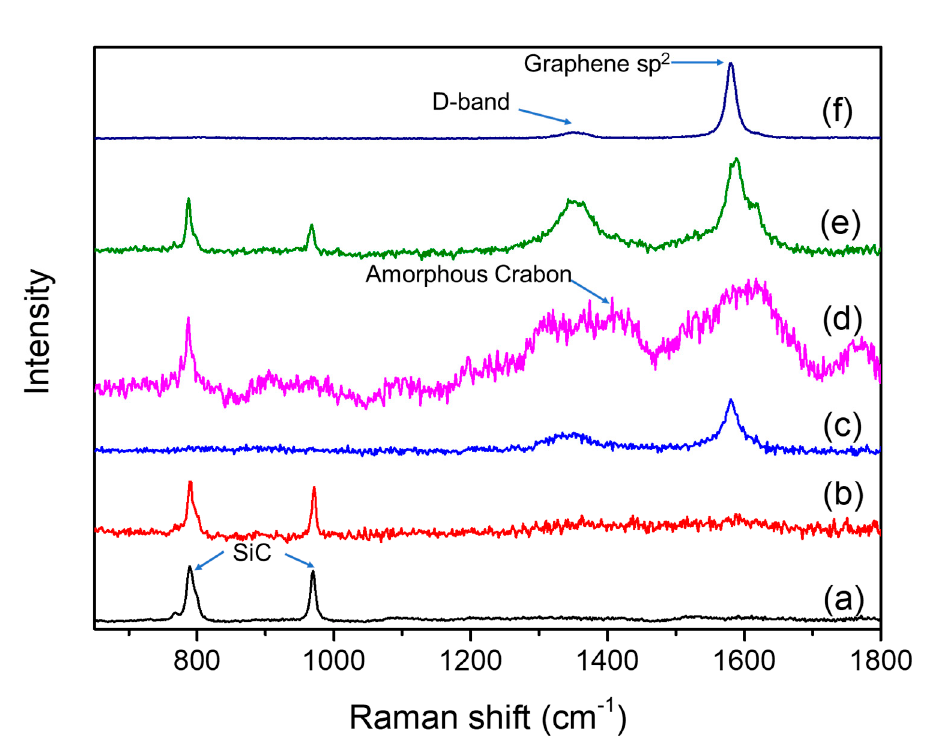
Figure 6. Raman spectroscopies of the samples: ( a ) in the grain of 0 M; ( b ) in the grains of 0.1 M; ( c ) intergranular of 0.1 M; ( d ) in the grain of 2 M; ( e ) intergranular of 2 M; and ( f ) freshly prepared graphene suspension.